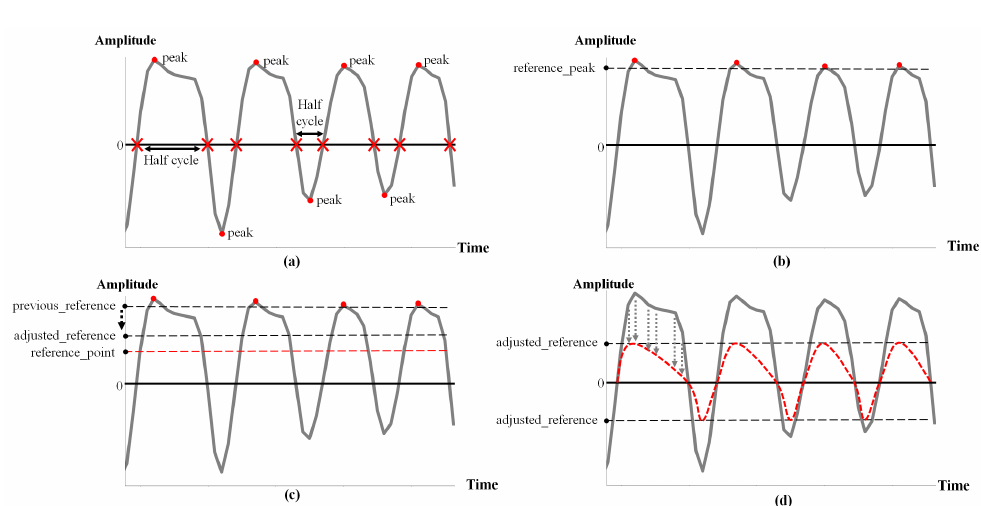
Figure 4. ( a ) Half-cycle detections of the PPG signal; ( b ) Distribution of the reference peaks; ( c ) Ad- justed reference point; ( d ) Results of the scaled PPG